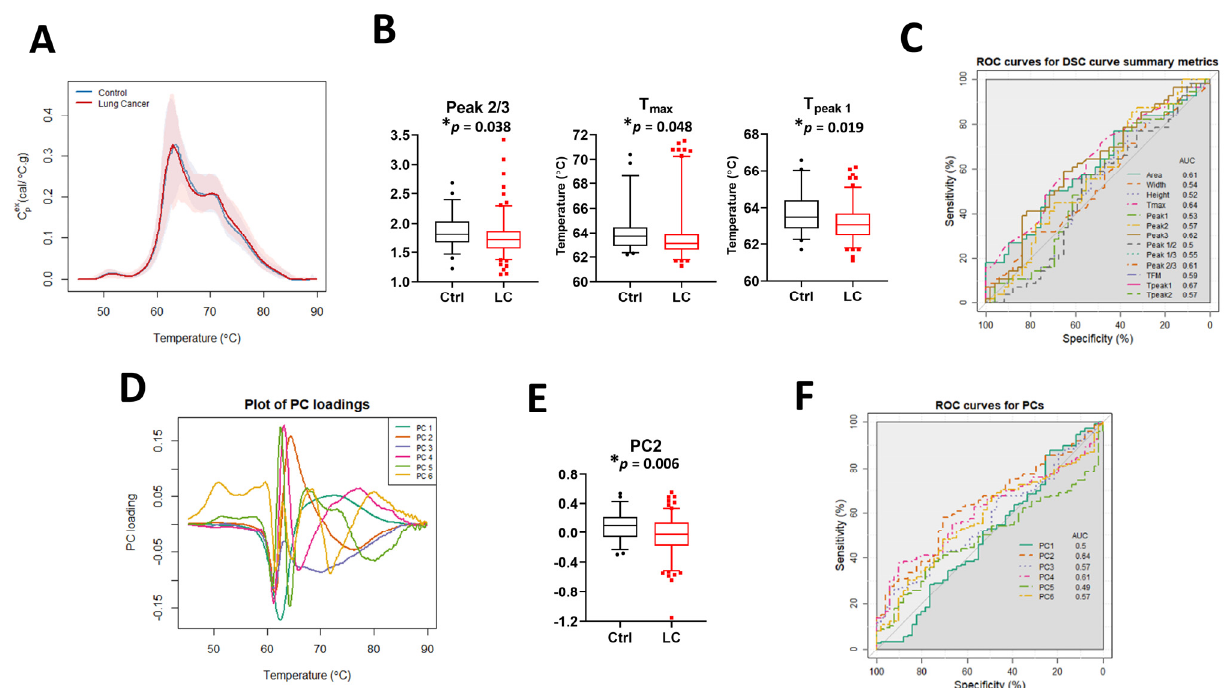
Figure 2. The potential utility of summary metrics and principal components to differentiate LC patients from controls. ( A ) Plot of the median DSC curve value at each temperature for LC and control subjects. Bands represent the 5th and 95th percentiles among subjects at each temperature. ( B ) Boxplots of selected summary metrics calculated from DSC curves for LC patients and controls. ( C ) Classification performance of the summary metrics determined by receiver operating characteristic (ROC) curves. ( D ) Plot of selected PC loadings at each temperature. ( E ) Boxplots of PC2 values calculated from DSC curves for LC patients and controls. ( F ) Classification performance of PCs as determined by receiver operating characteristic (ROC) curves. *, adjusted p -value < 0.05. Table 2. Selected associations between summary metrics/PCs and the clinical group. Summary metrics/PCs were dichotomized based on either the median value or interquartile range (IQR) calculated for control subjects. Parameter